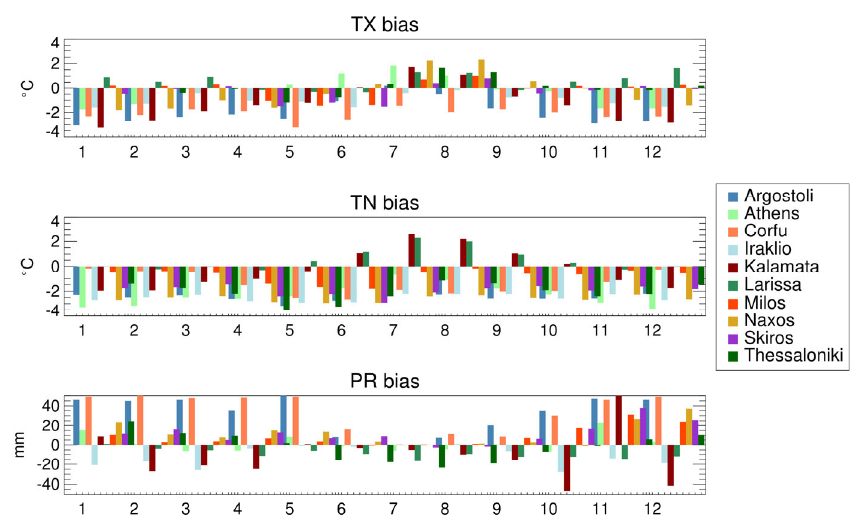
Figure 3. Biases in monthly statistics of daily TX, TN, and PR based on the model data for the period 1971–2000 in 10 representative Greek stations.